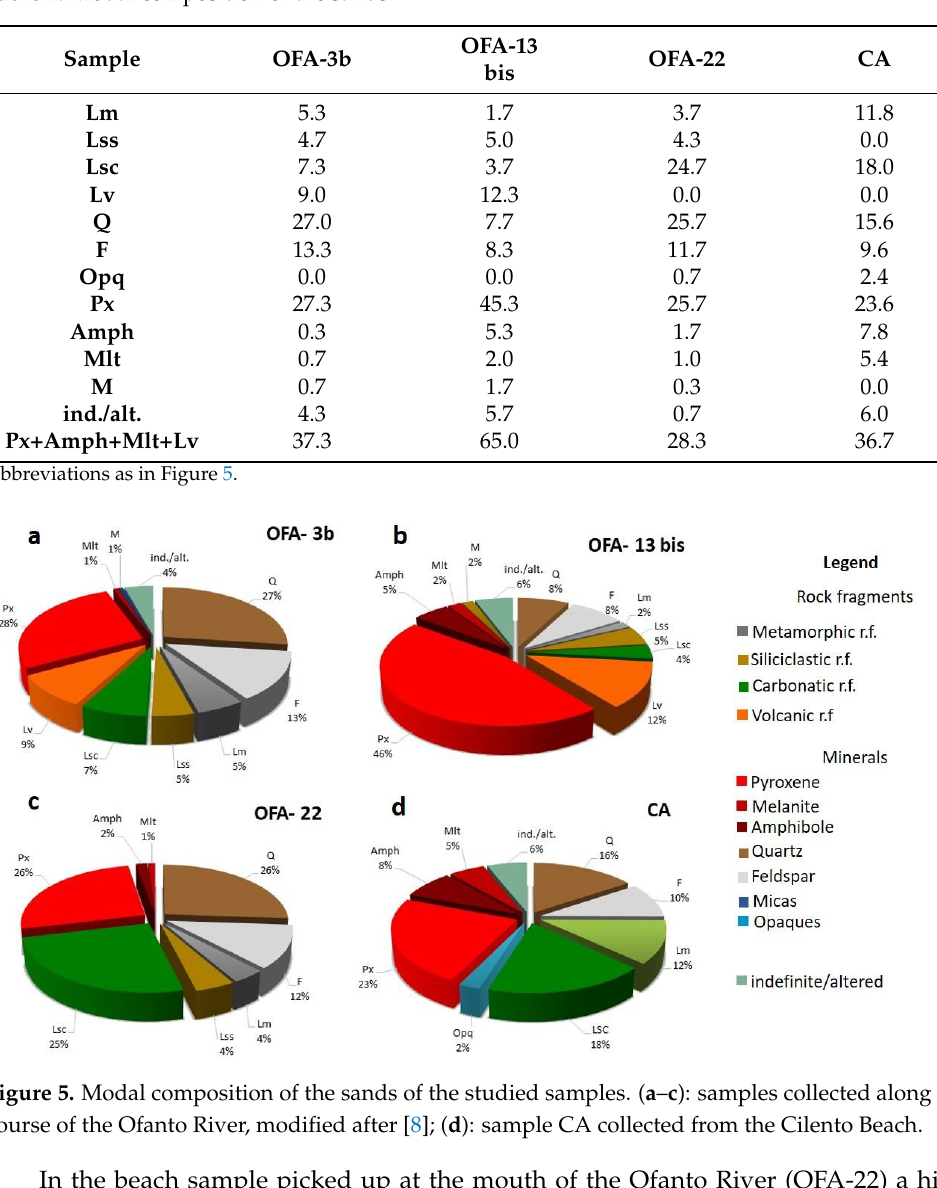
Abbreviations as in Figure 5.